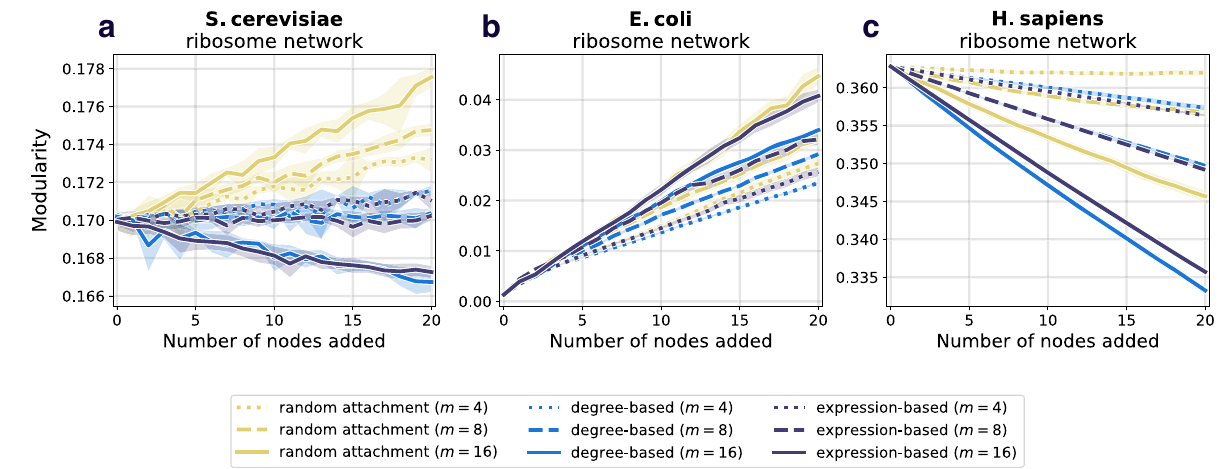
Fig. 5 Prospective modularity of three ribosomal networks. As a comparison measure, we also examine how the modularity of the network changes following the addition of new nodes. The color scheme and line styles are the same as in Fig. 4. a Prospective modularity of S. cerevisiae ribosomal network. b Prospective modularity of E. coli ribosomal network. c Prospective modularity of H. sapiens ribosomal network. Crucially, we do not fi nd any evidence that the prospective resilience results observed in Fig. 4 are being driven by the change in the networks' community structures, as the plots here show highly divergent patterns, suggesting that there is a more distinct mechanism underlying prospective resilience.